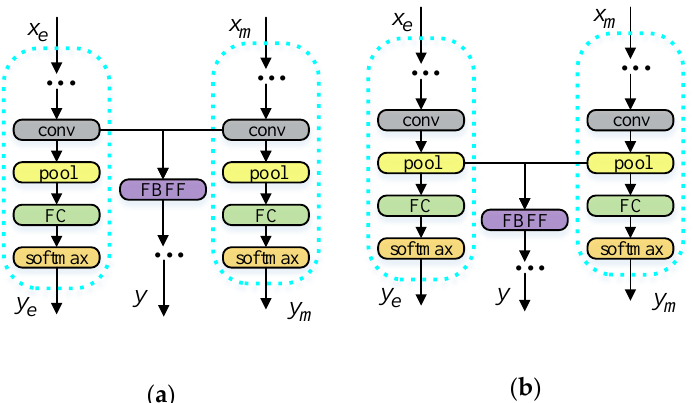
Figure 7. Structure chart of the feature fusion of different convolution layers. ( a ) The feature fusion of the convolutional layer before global average pooling. ( b ) The feature fusion of the convolutional layer after global average pooling.